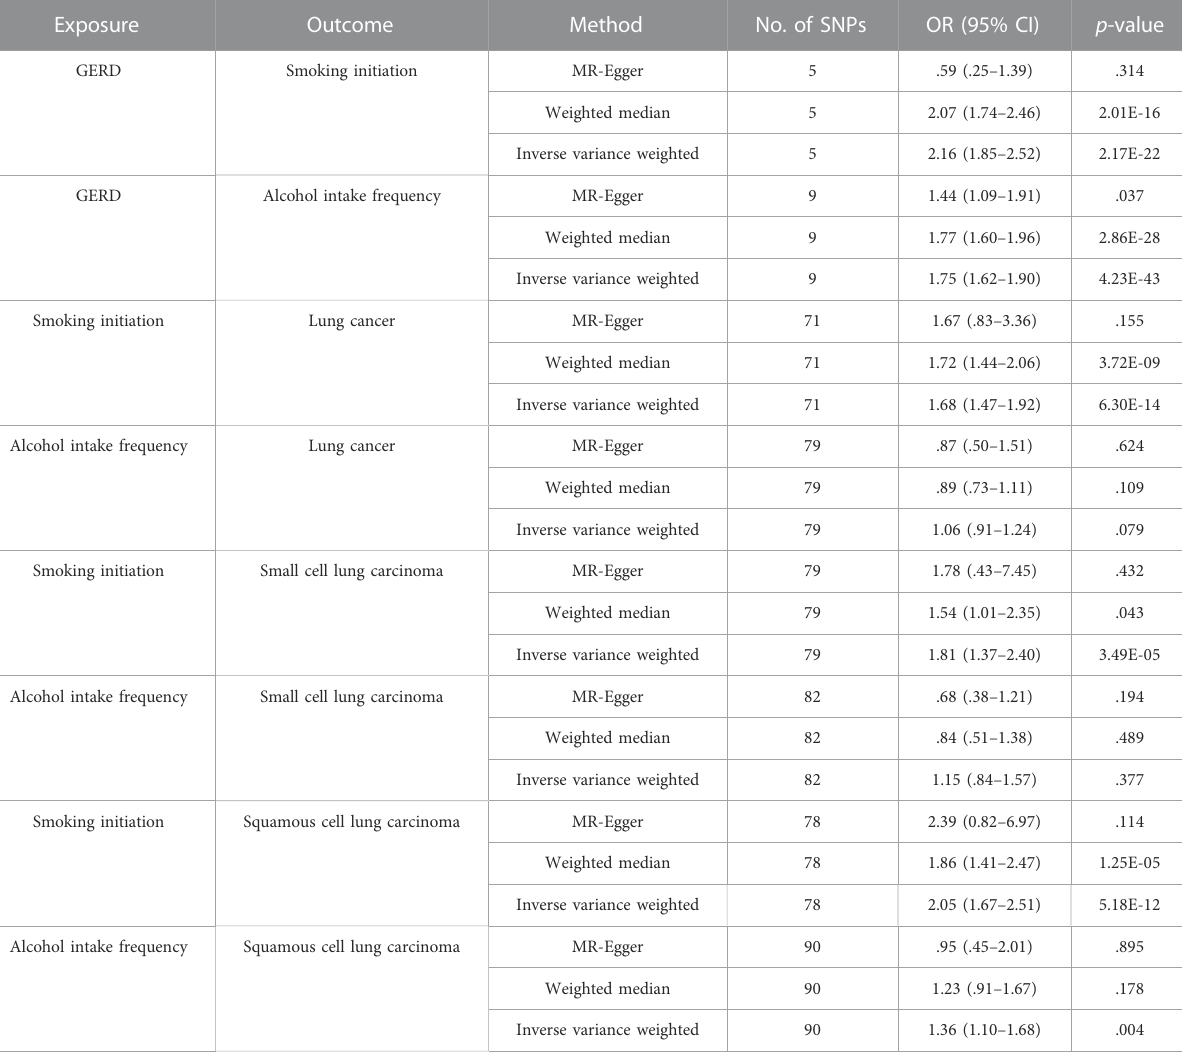
TABLE 2 Two-step MR estimates of GERD on mediators and mediators on lung cancer.